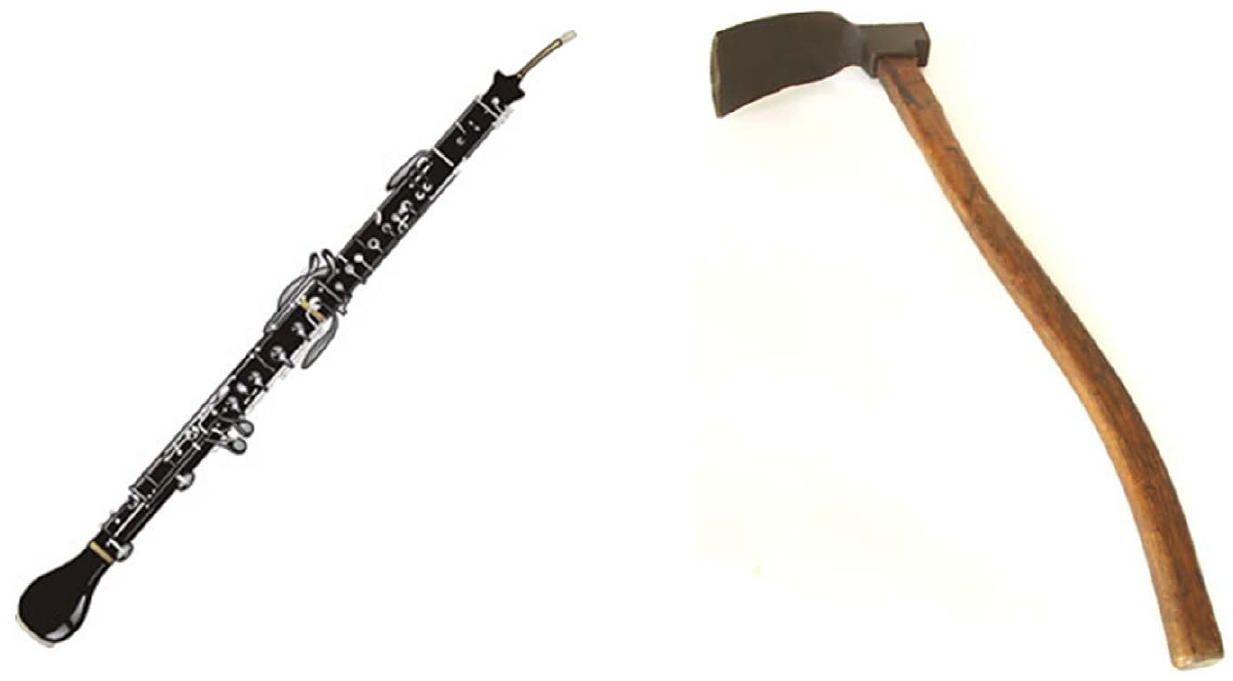
Figure 1. Objects from unfamiliar categories. On the left a cor anglais (a woodwind instrument), on the right an adze (a woodworking tool).